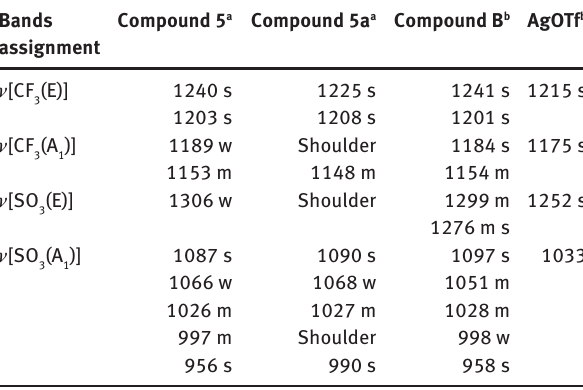
Table 1 Data of IR spectroscopy for compounds 5 , 5a , B , and AgOTf. Bands